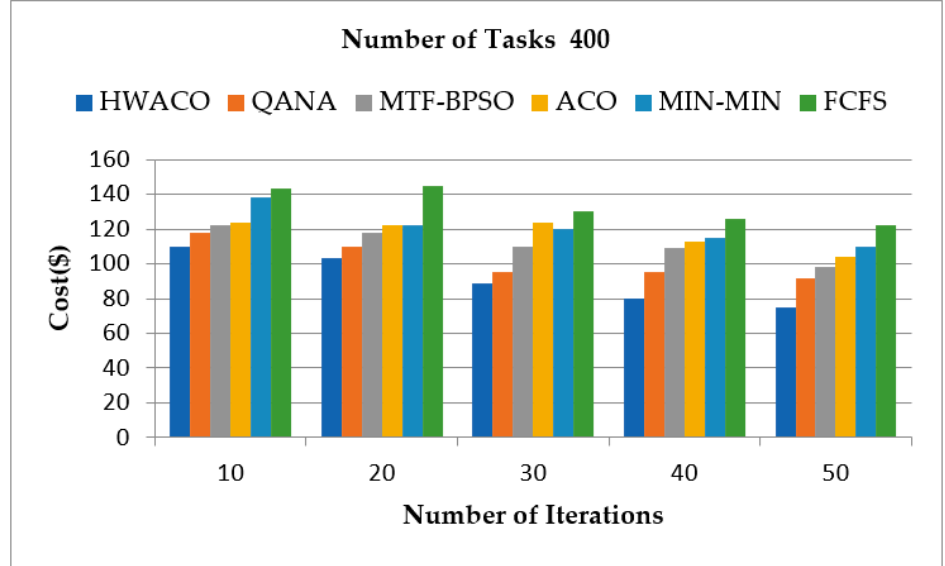
Figure 7. The task cost values of 400.